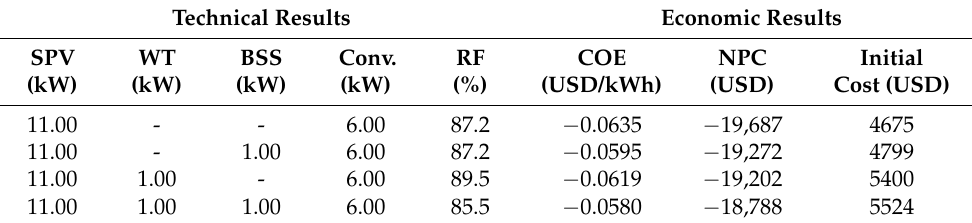
Table 2. Techno-economic planning results for Scenario